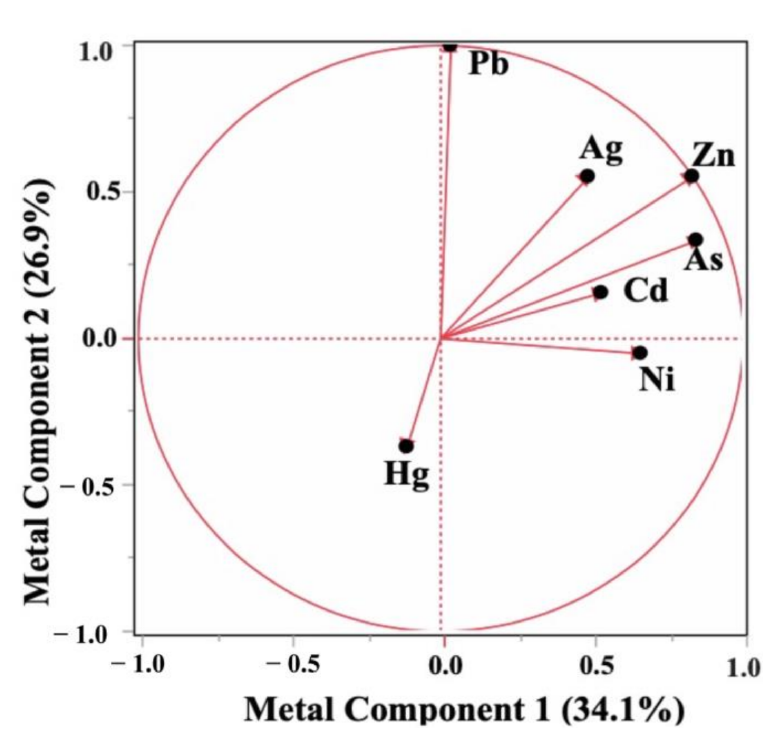
Figure 2. Component loadings from multivariate factor analysis using JMP ® 14 (SAS 2019). Analysis was conducted on the correlations matrix using the maximum likelihood and varimax rotation method. The XRF detected metals (Ag, Zn, As, Cd, Ni, Pb, and Hg in ppm) were factored into two linear components (Component 1 and 2) which represented 61% of the total variation. Data were from sediments collected from wetland sites 1–6 sampled during 2015–2017. The plot shows rotated factor loadings relative to each component in the multivariate